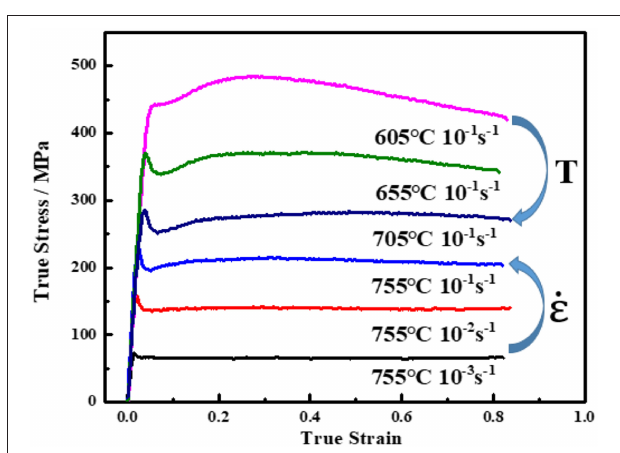
FIGURE 3 | Flow curves under different temperatures and strain rates from the thermal compression test of experimental alloy.